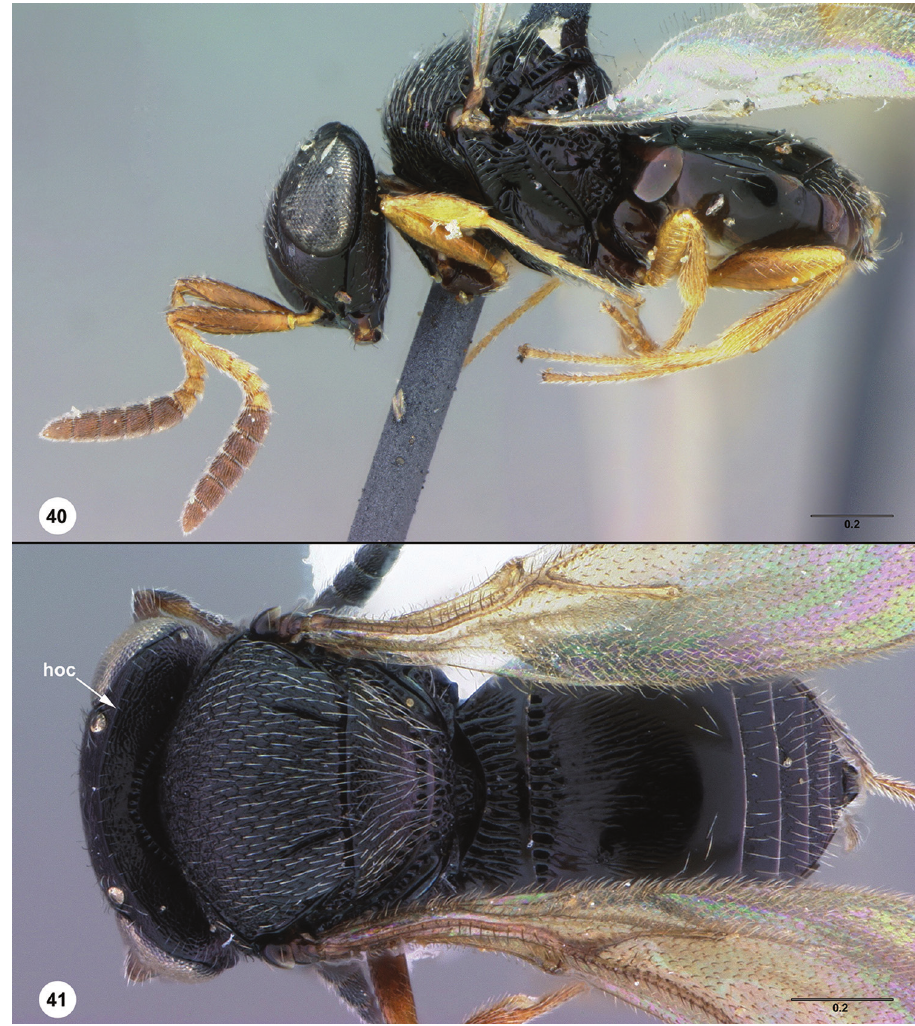
Figures 40–41. Trissolcus cultratus 40 female lectotype (NHMW 0008A), head, mesosoma, metasoma, lateral view 41 female (USNMENT00916251), head, mesosoma, metasoma, dorsal view. Scale bars in millimeters.